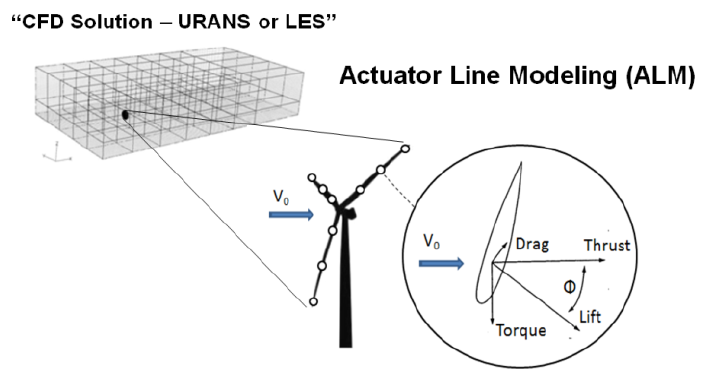
Figure 2. Basic concept of the Actuator Line Method (ALM) for modeling wind turbine